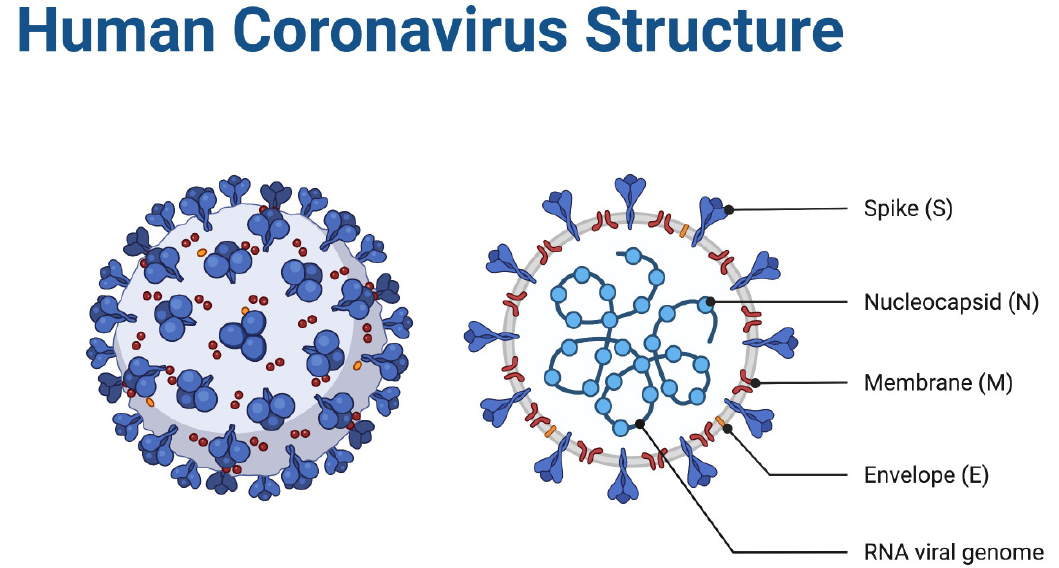
Figure 6. A schematic representation of SARS-CoV-2 structure. It is enveloped and contains a positive-sense RNA virus with four main structural proteins such as the spike (S), membrane (M) glycoproteins, the envelope (E) and the nucleocapsid (N) proteins. Created with BioRender.com. COVID-19 patients can have immunological memory cells from previously encoun- tered pathogens before infection that can recognize the epitope on SARS-CoV, SARS-CoV2 and other human coronaviruses [200–204]. Specifically, recent analyses have identified cross-reactive memory T cells of the adaptive immune system that recognize SARS-CoV-2 in addition to other viruses [201,203,204]. In two separate studies of blood samples, re- searchers found that people unexposed to SARS-CoV-2 had memory CD4 + T cells endemic to human coronaviruses, including (HCoV)-OC43, HCoV-229E, HCoV-NL63, and HCoV- HKU1 that also recognized SARS-CoV-2 [201,204]. These HCoV-specific T cells recognize common epitopes between SARS-CoV-2 and common cold coronaviruses, with S proteins the most frequently recognized antigen